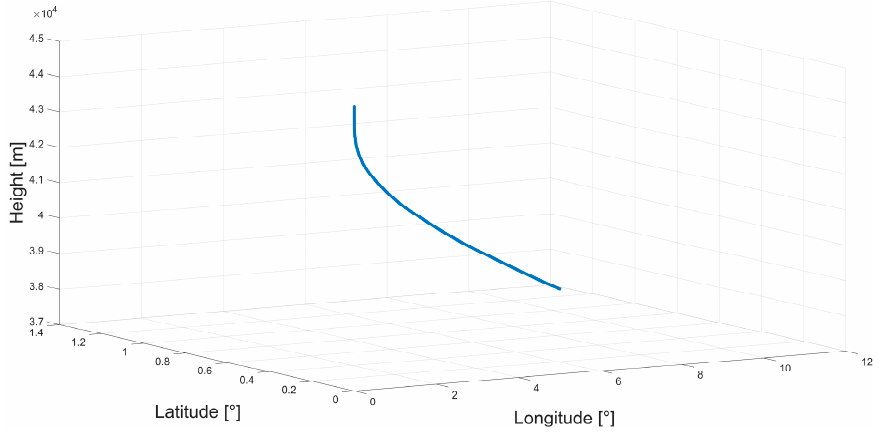
Figure 5. The equilibrium glide trajectory of the non-cooperative target.